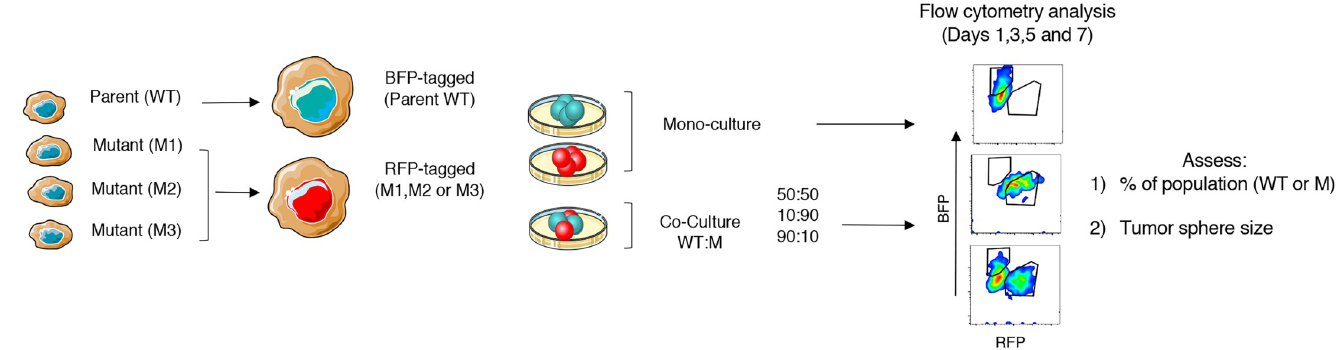
Fig 3. Lentiviral tagging and flow cytometry strategy. WT and mutant cells were induced to constitutively express blue and red, respectively, fluorescence by lentiviral transfection. Cells were then cultured alone (monocultures) or WT and mutant together (co-cultures) in 3-D culture at density ratios of 50:50, 90:10, and 10:90. The % of cells in the tumor sphere population and the size of the tumor sphere were measured by flow cytometry twice at 48 hour intervals in the presence or absence of drug.